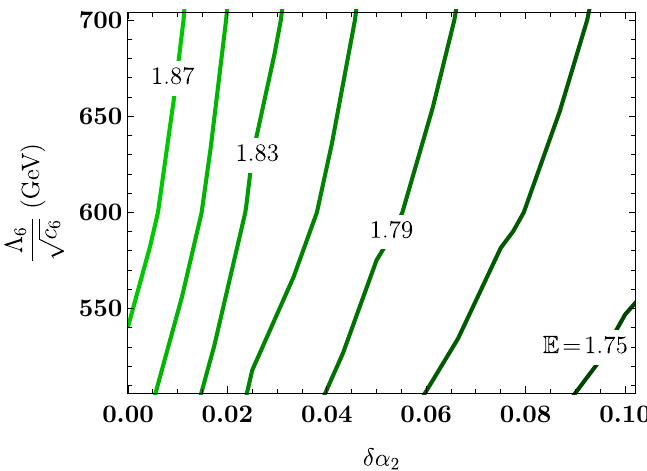
Figure 5 . Contours of the sphaleron energy in units of 4 (cid:25)v=g 2 as a function of both (cid:14)(cid:11) 2 and p (cid:3) 6 = c 6 , as de(cid:12)ned in eq.